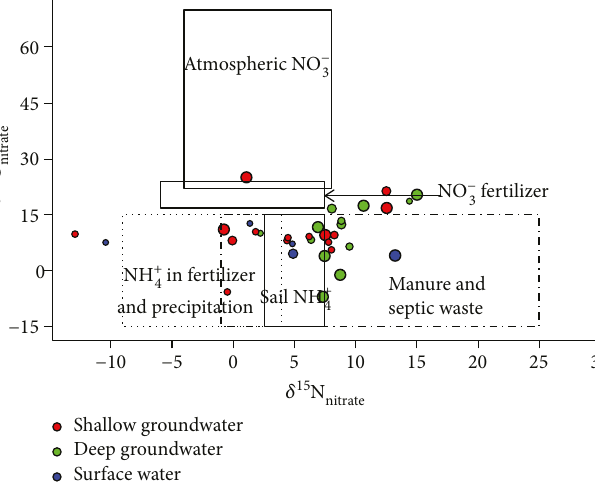
Figure 4: Dual-isotope method for nitrate source attribution in groundwater, September 2012. Modi fi ed from Fenech et al. [33].